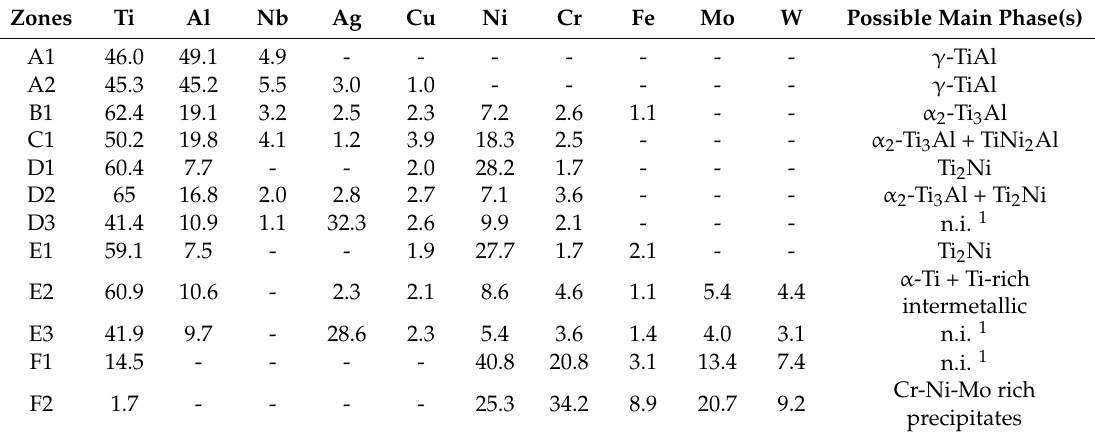
Figure 5. BEIs of γ -TiAl alloy/Hastelloy interface produced after joining at 980 °C. Table 1. Energy dispersive X-ray spectroscopy (EDS) chemical composition (at.%) of typical zones detected in γ -TiAl alloy/Hastelloy joints produced at 980 °C.